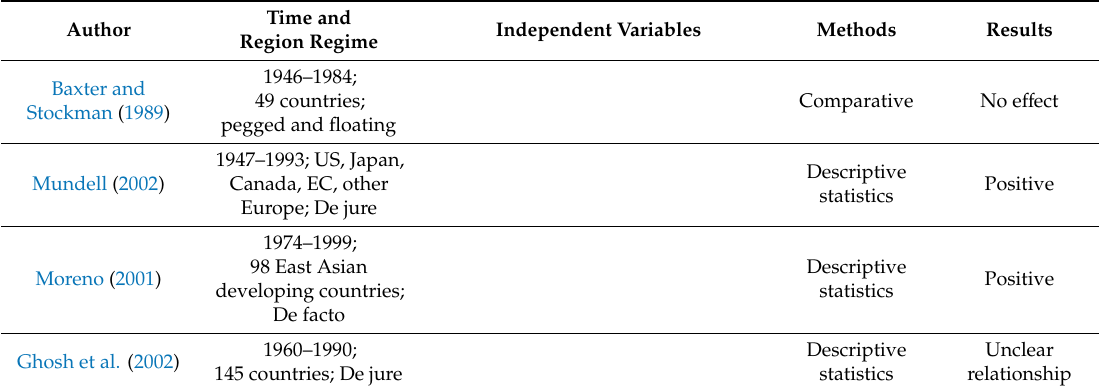
Table 1. List of explanatory variables used in previous